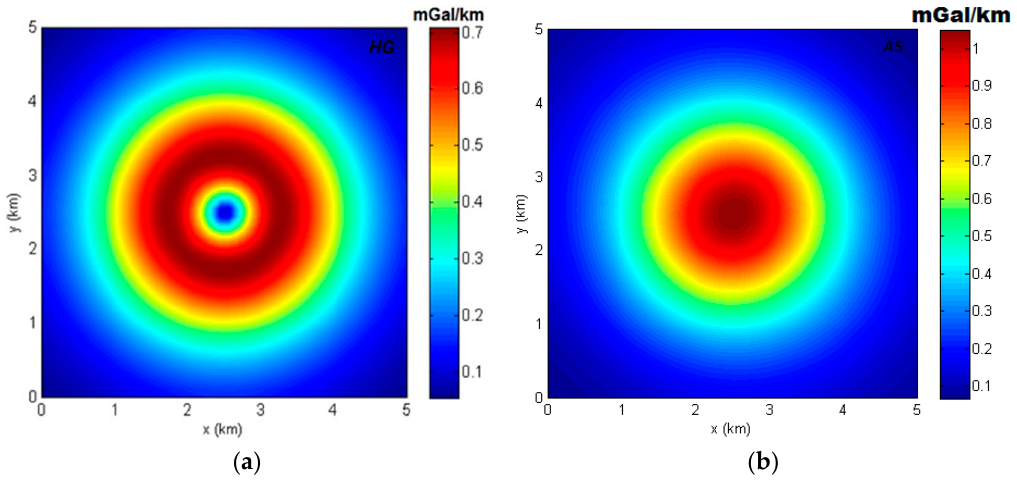
Figure 8. ( a ) the horizontal gradient of a rectangular prism; ( b ) analytic signal of a rectangular prism. The horizontal gradient and analytic signal are positive values due to the square roots of the x- , y- , and z -gradients. The horizontal gradient value ranges from 0.1 mGal/km to 0.7 mGal/km, while the analytic signal is in a range between 0.1 mGal/km to 1 mGal/km.